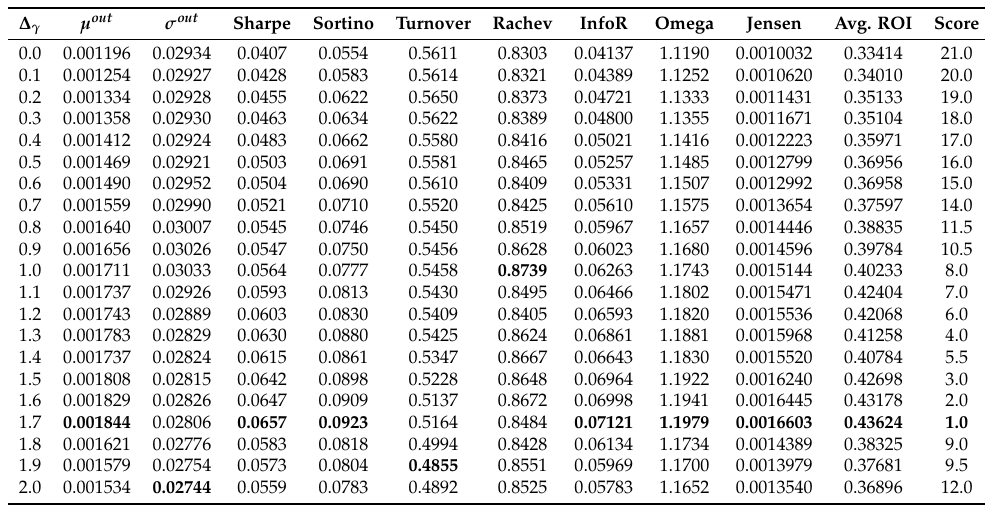
Table 1. ES50: out-of-sample performance results for the RMZ R strategy by varying ∆ γ , where ∆ γ is the skewness parameter and score is the median value of the overall performance rankings. The best results are marked in bold.